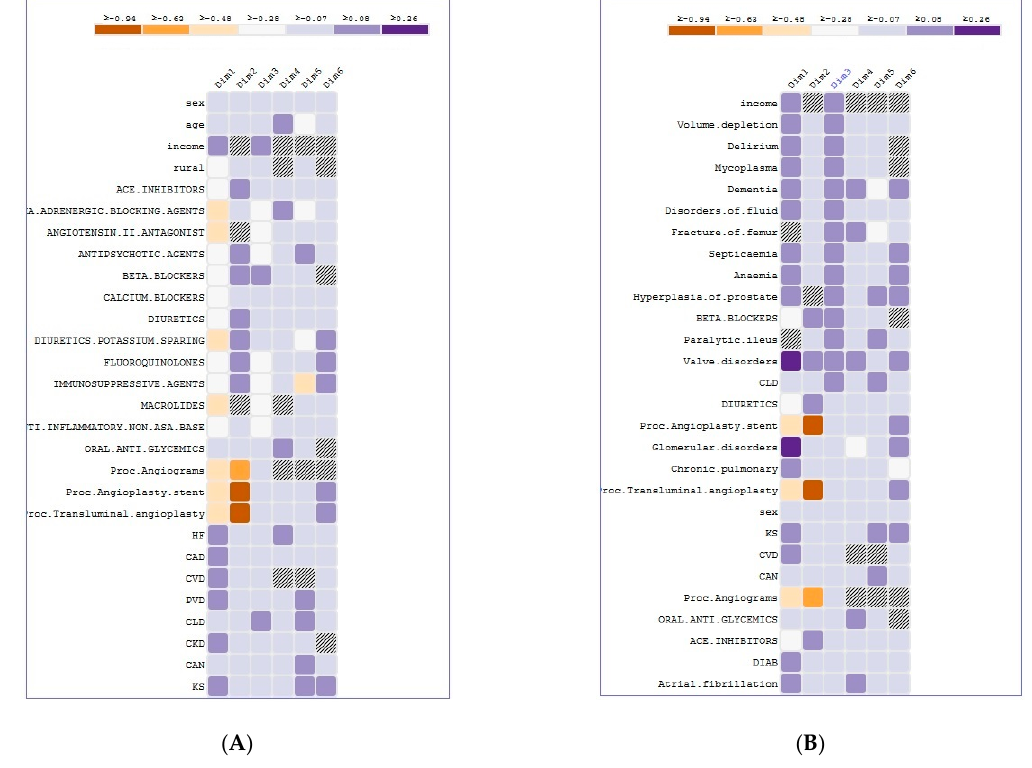
Figure 6. Showing an overview of the association subview, which includes ( A ) a heatmap representing the association between six dimensions and 44 features and ( B ) a heatmap where all the features are sorted in a descending order based on dimension three.